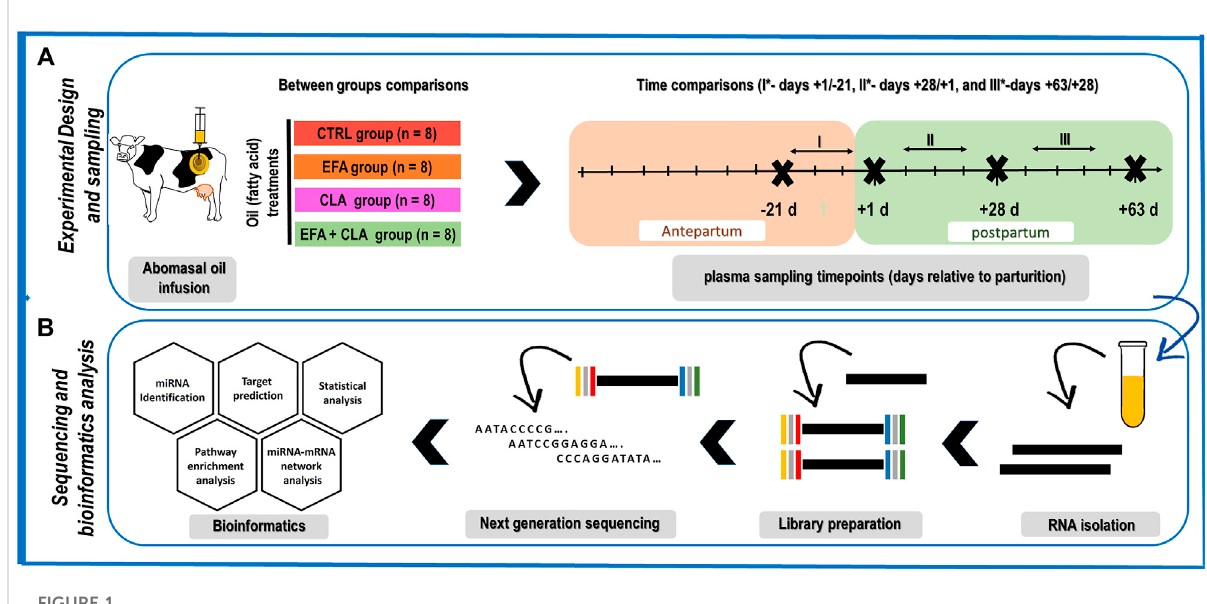
FIGURE 1 Schematic representation of (A) the animal experimental design and sampling time points, consisting of four groups CTRL: control (n = 8), EFA: essentialfattyacids( n =8),CLA:conjugatedlinoleicacid( n =8),andEFA+CLA( n =8),andfourplasmasampling(days − 21,+1,+28,and+63relative to parturition). The focus of this study is primarily on time comparisons since the effect of treatments was negligible (B) Sequencing analysis and bioinformatics. CTRL: control, EFA: essential fatty acids, CLA: conjugated linoleic